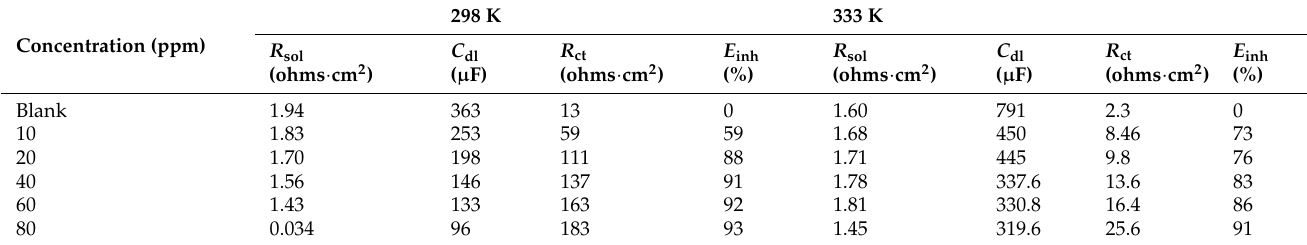
Table 2. EIS parameters of low-carbon steel corrosion in 1 M HCl in the absence and presence of CoO/Co 3 O 4 NPs at 298 and 333